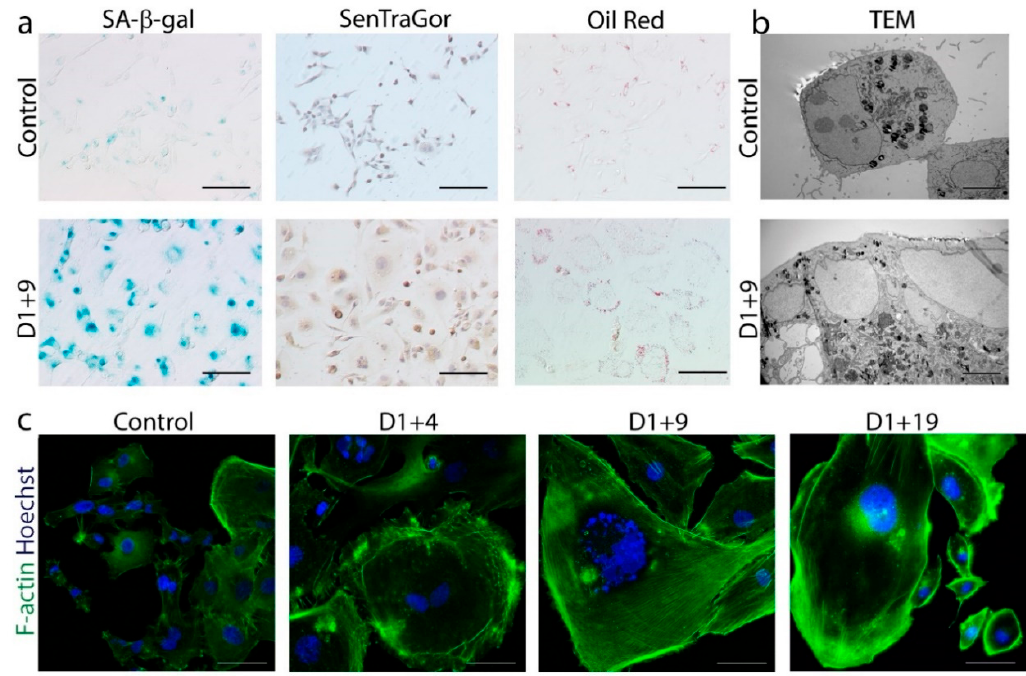
Figure 1. Markers of senescence in dox-treated MDA-MB-231 cells. Cells were treated with 100 nM doxorubicin for 24 h, then cultured in a fresh medium and analyzed on subsequent days. ( a ) Immunocytochemical staining visualized the activity of SA- β -gal (cells stained blue), the accumulation of lipofuscin detected by SenTraGor (cells stained brown) and the accumulation of neutral lipids detected by Oil Red O (red lipid droplets within the cytoplasm). Scale bar: 50 μ m. ( b ) Representative transmission electron microscopy images of cross sections showing increased size and number of vacuoles and lipid droplets. Scale bar: 5 μ m. ( c ) Representative immunofluorescence images of cell morphology. Cells were stained for F-actin (green), nuclei were stained with Hoechst (blue). Scale bar: 50 μ m.